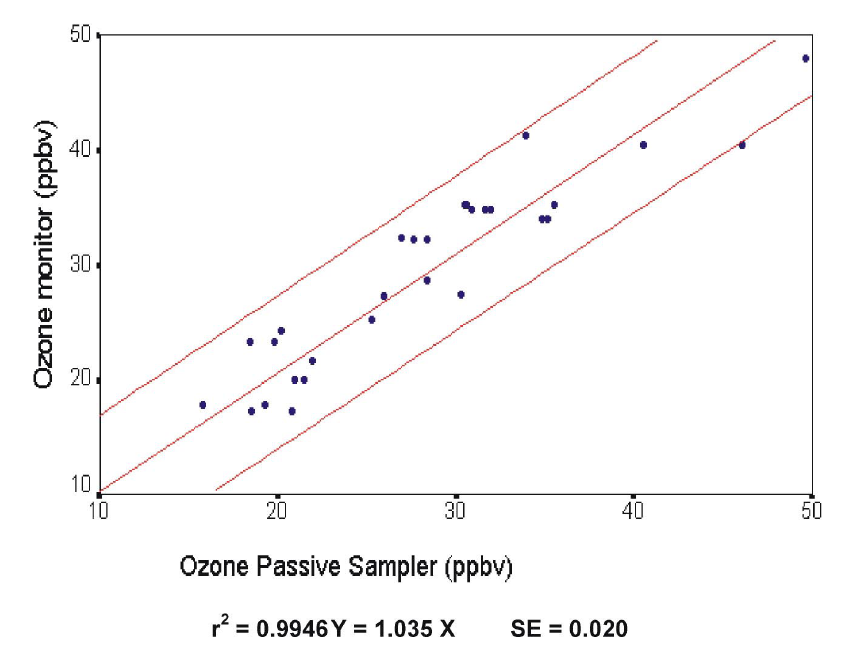
FIGURE 2. Linear regression between the passive sampling and the continuous monitor concentrations for locations M1, M2, and M3. Lines indicate 95% confidence